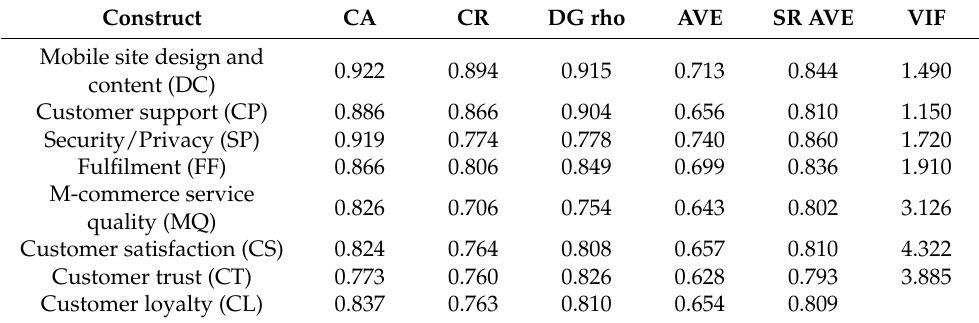
Table 3. The measurement model